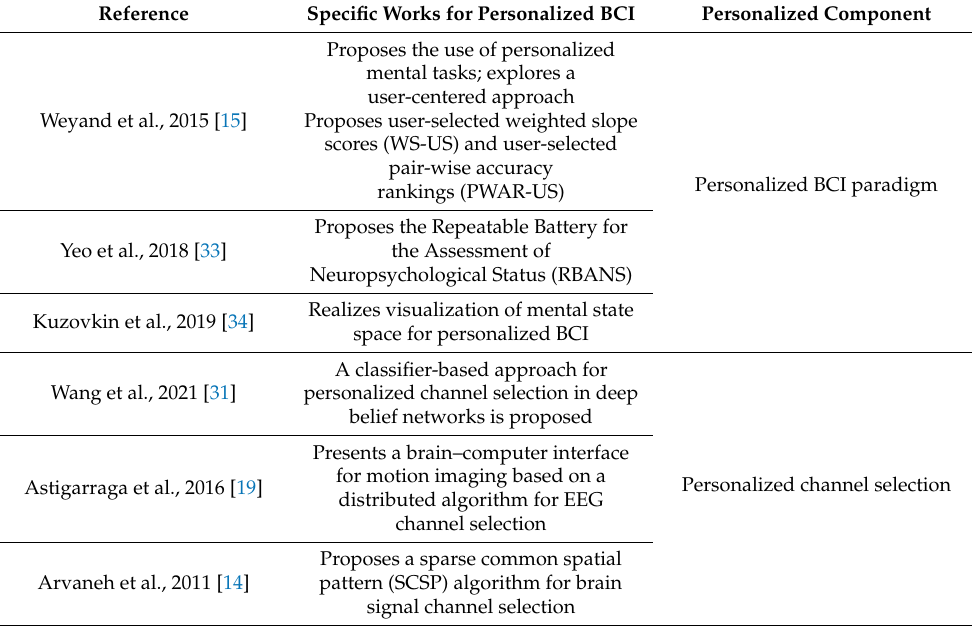
Table 1. Studies on personalized BCI